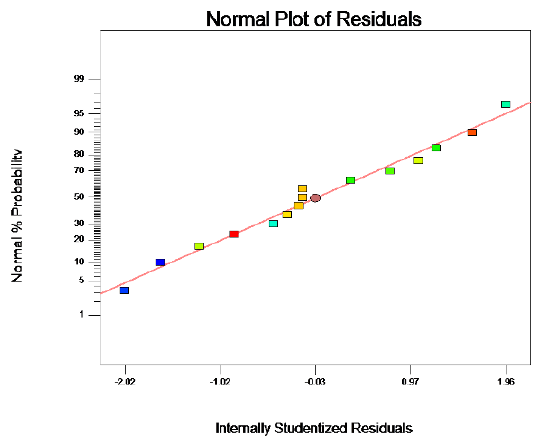
Figure 5. Normal plot of residuals showing the relationship between normal probability (%) and internally studentized residuals.